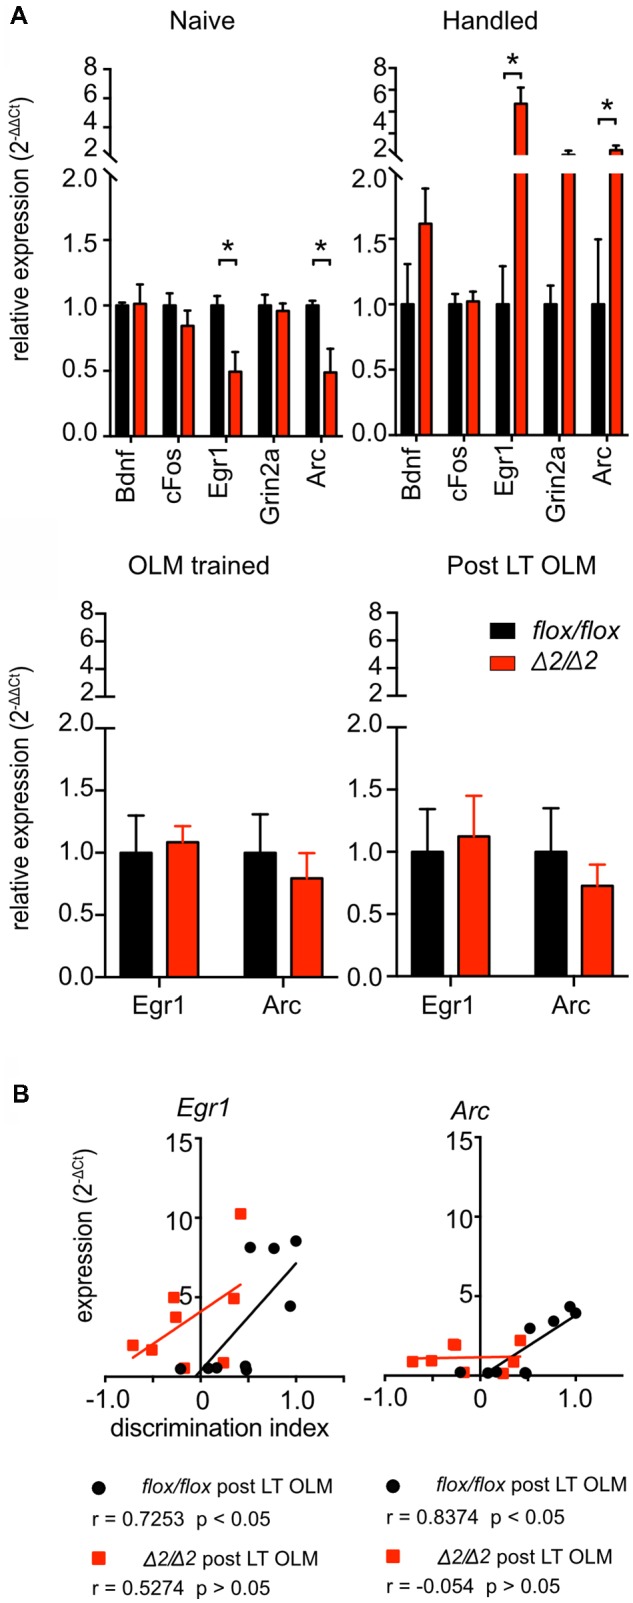
Dysregulation of immediate early genes (IEG) in the hippocampus of Chd1Δ2/Δ2 animals. (A) Reverse transcription real-time PCR was performed on RNA from dorsal hippocampi (dHC) isolated from Chd1Δ2/Δ2 and Chd1flox/flox mice kept in their home cage (“naïve”; n = 4/4), mice from both groups that were habituated to the test arena but not trained or tested (“handled”; n = 3–4/group), animals that were sacrificed 30 min after long-term OLM training (“OLM trained”; n = 4/4) or 30 min after long-term OLM testing (“Post LT OLM”; Chd1flox/flox
n = 9, Chd1Δ2/Δ2
n = 8). (B) Expression of Egr1 and Arc correlates with the performance (discrimination index) of the respective Chd1flox/flox mice in the OLM test, while no such correlation was detected for Chd1Δ2/Δ2 animals. Correlation coefficients (r) and p values are shown in the figure legends. Statistical analysis was performed by pairwise t-test with Holm-Sidak correction for multiple testing for (A) and using the built-in correlation analysis tool of GraphPad Prism 7 for (B). p < 0.05 was considered significant (*p < 0.05).